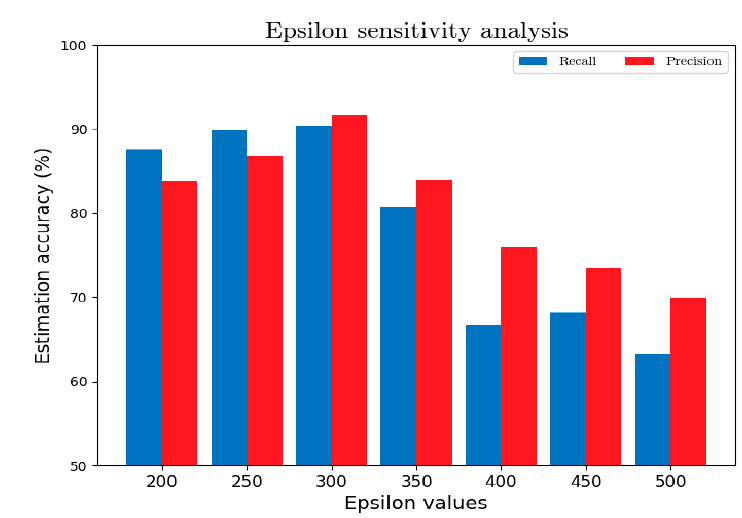
Figure 16. Effects of the ε -value on the fingerprinting performance. (3) The searching radius of anchor map